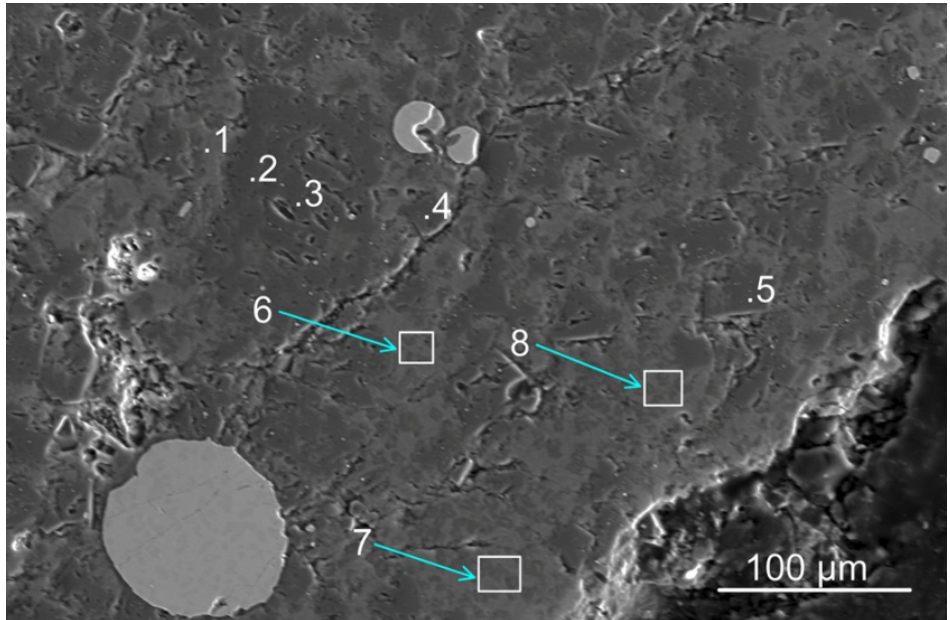
Figure 5. BSE image of slag area at the slag–weld metal interface: MP3 slag sample. (See Table 6 for the analyses of the numbered phases in Figure 5). Table 6. SEM analyses of marked phase positions in Figure 5 (mass%).